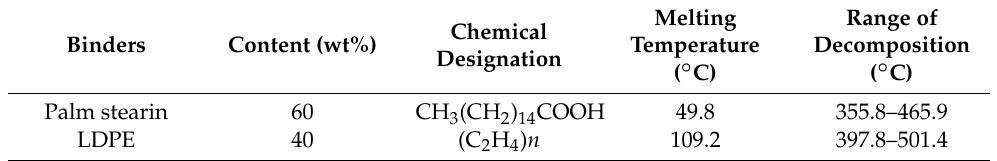
Figure 1. Morphologies of the powders: ( a ) FESEM image of 17-4PH stainless steel particles; ( b ) TEM image of zirconia particles. Table 1. Properties and characteristics of the